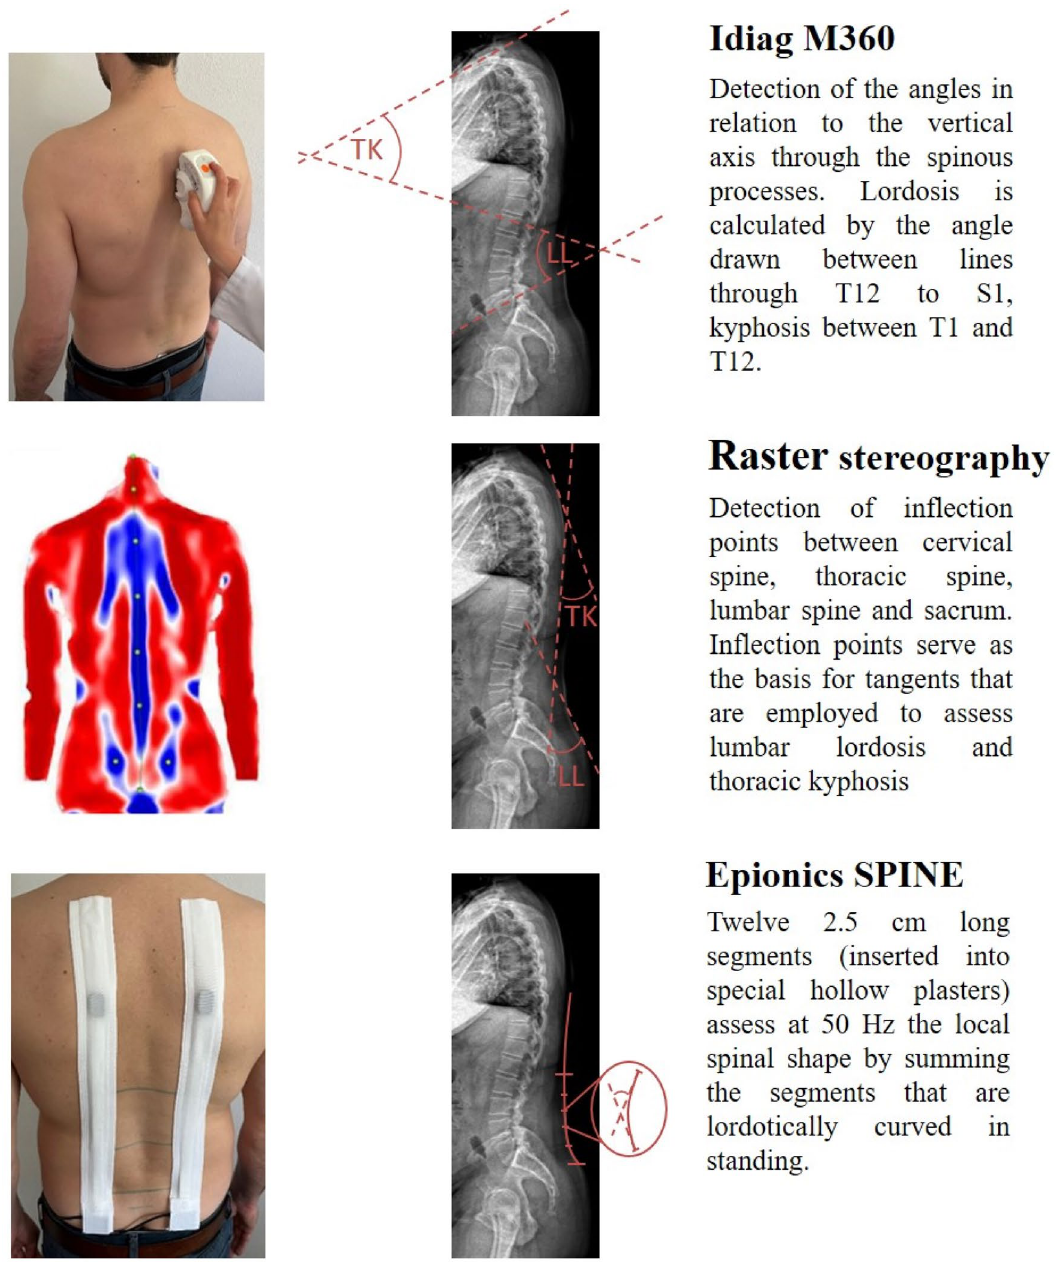
Figure 1. Comparison of the measurement devices and their definition for the lordosis and kyphotic Raster sterography (Formetric III). The raster stereography is a non-radiological photogrammetric method that bases on the principles of triangulation. A system of light-lines is projected onto the subject’s back and subse- quently distorted as a function of the three-dimensional back surface, with the aim to reconstruct the individual spinal shape 28,29 . The system is able to determine the inflection points between cervical spine, thoracic spine, lumbar spine and sacrum in the median sagittal plane as well as specific back surface landmarks such as the spinous process automatically. Therefore the spinous processus C7 is detected as the spinous process closest to the inflection point between thoracic kyphosis and cervical lordosis. These inflection points serve as the basis for tangents, which are employed to assess LL and TK as seen in Fig. 1. The system does not allow the determi- nation of maximal range of flexion or range of extension during maximal upper body bending. In the present study, the measurement mode “3D-Average” was employed, which averages 30 measurements in 5 s to account for small posture variations. The system’s reliability in particular for sagittal plane parameters was investigated previously 20–22 and a detailed description of the system can be found elsewhere 30,31 . Epionics SPINE. The Epionics SPINE uses strain-gauge measurement technology for the detection of back shape and motion. Two flexible sensor strips that consist of each twelve 2.5 cm long segments (inserted into